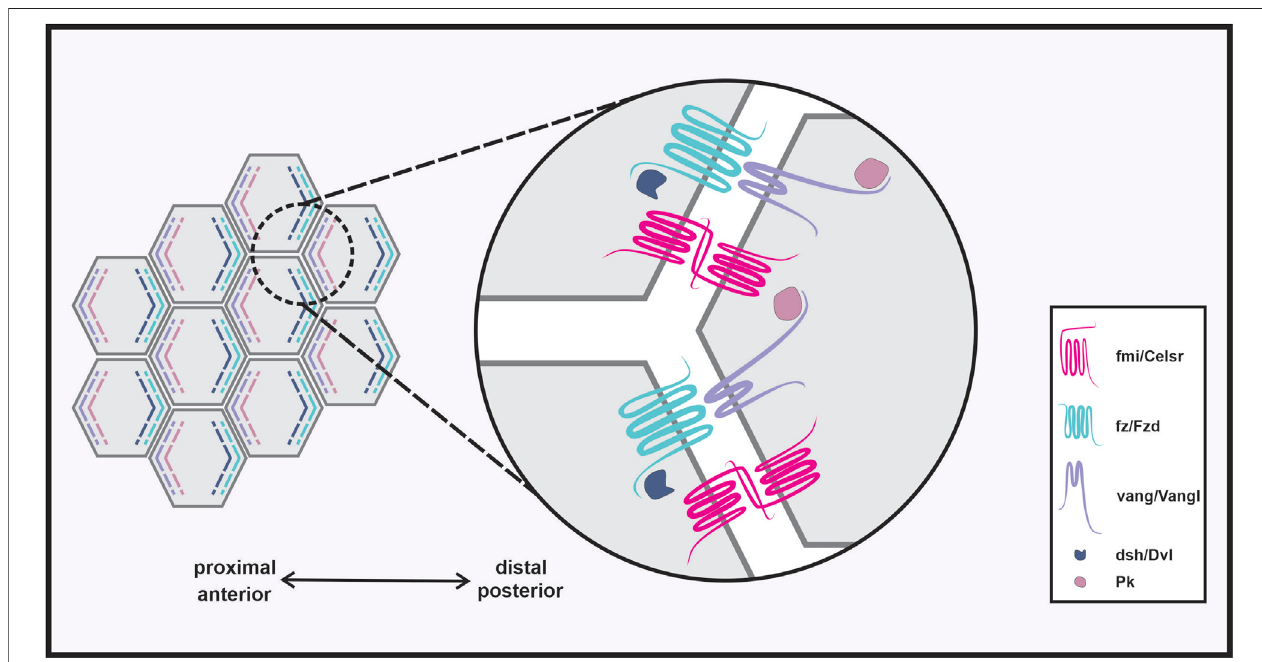
FIGURE1| Establishmentofplanarcellpolarity.Planarcellpolarity(PCP)istheorganizationofcellsacrossatissueplaneorthogonaltotheapical-basalaxis.PCPis established through asymmetric distribution of corecomponent complexes, where Vangl-Pkand Fzd-Dvl complexes localize toopposite sidesof the cell. Cell polarity is maintained and propagated to neighboring cells through intercellular protein-protein interactions between opposing complexes, and homophilic interactions between Fmi/Celsr.